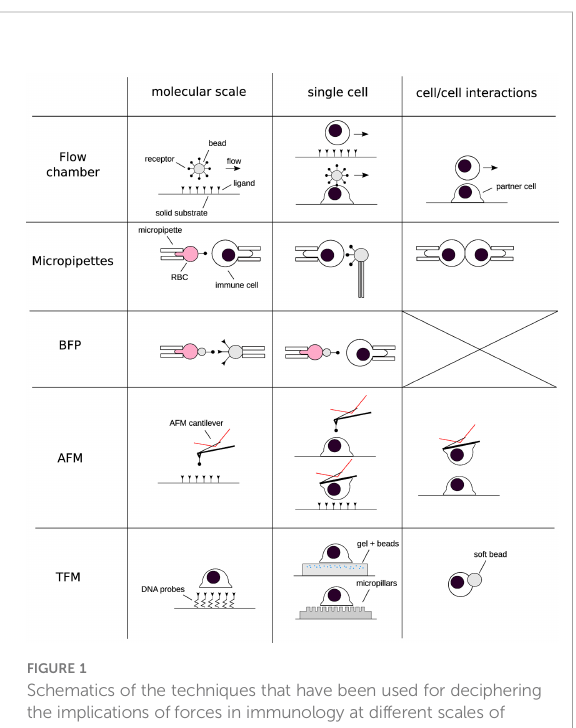
FIGURE 1 Schematics of the techniques that have been used for deciphering the implications offorces in immunology at different scales of space (from molecular to cell/cell interactions) and times. Each row represents a “ group ” of similar techniques, and each column a given spatial scale. A selection of references corresponding to each technique, restricted to their application to immune cells: Flow chamber: (10 – 12) Micropipettes: (13 – 16). Biomembrane Force Probe: (17 – 20). Atomic Force Microscopy: (21 – 26)